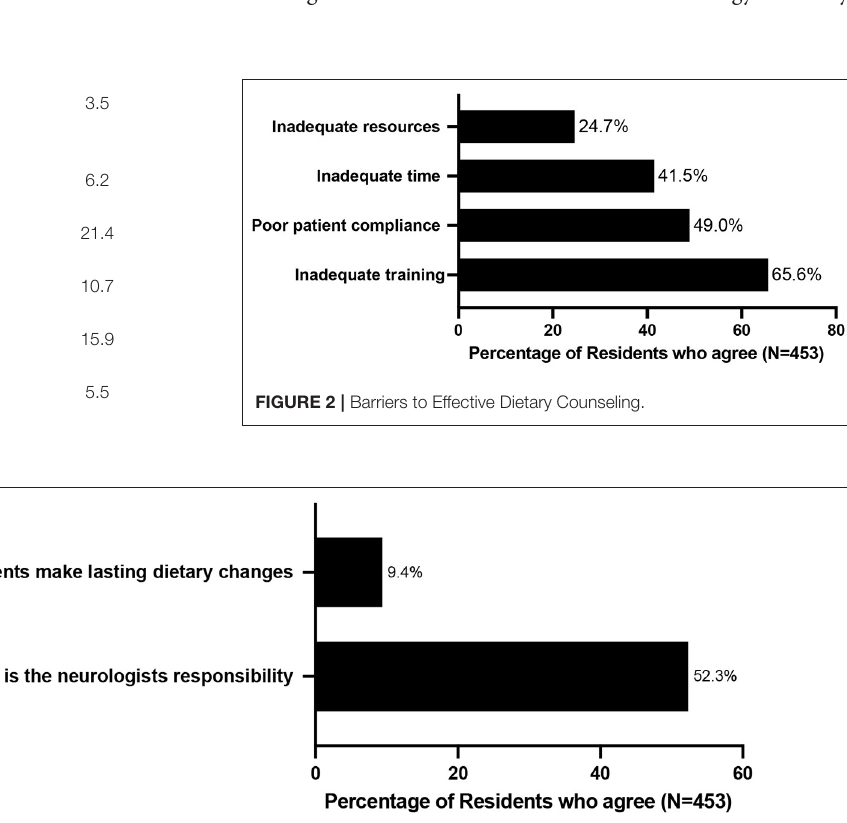
FIGURE 1 | Neurology Residents’ Attitudes and Beliefs Regarding Dietary Counseling and Barriers to Counseling.